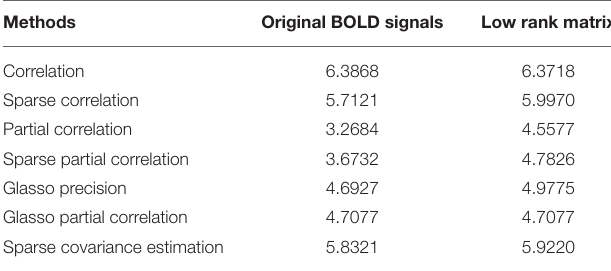
TABLE 1 | Percentage comparisons of significant